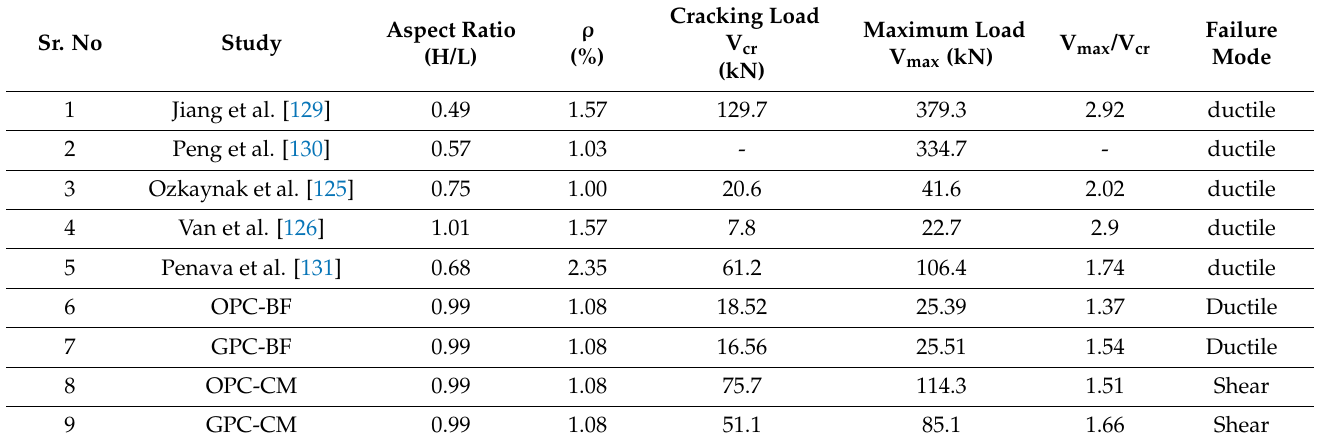
Table 8. Comparison of the present study with past studies on bare